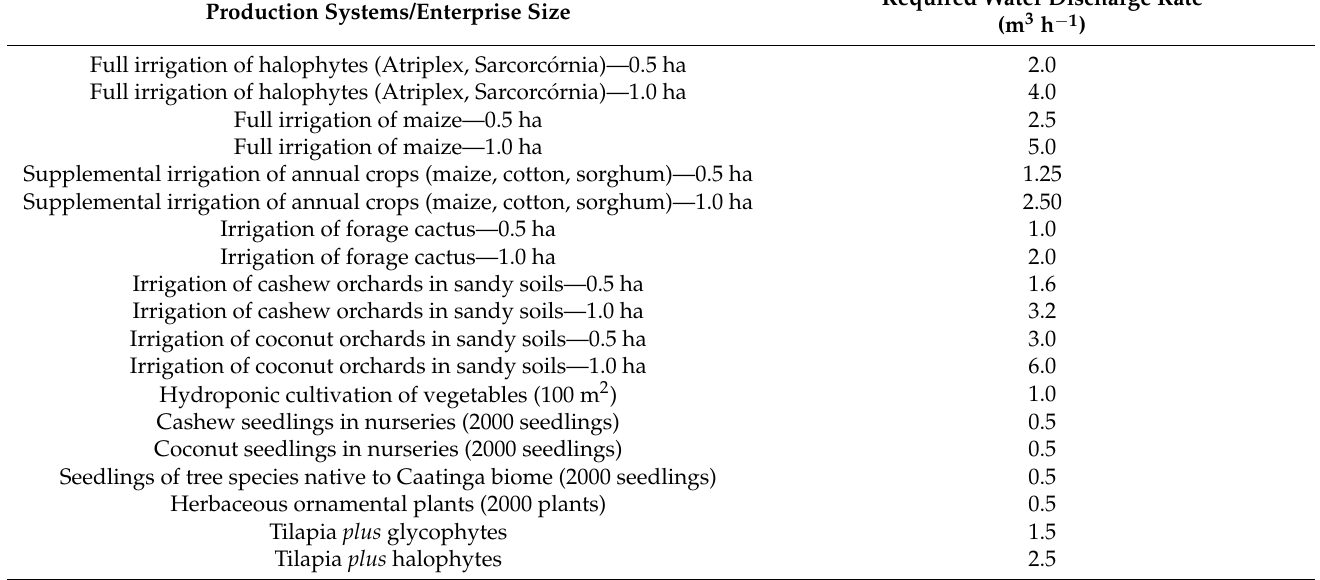
Table 3. Minimum discharge rates (Q) required of wells for each production system